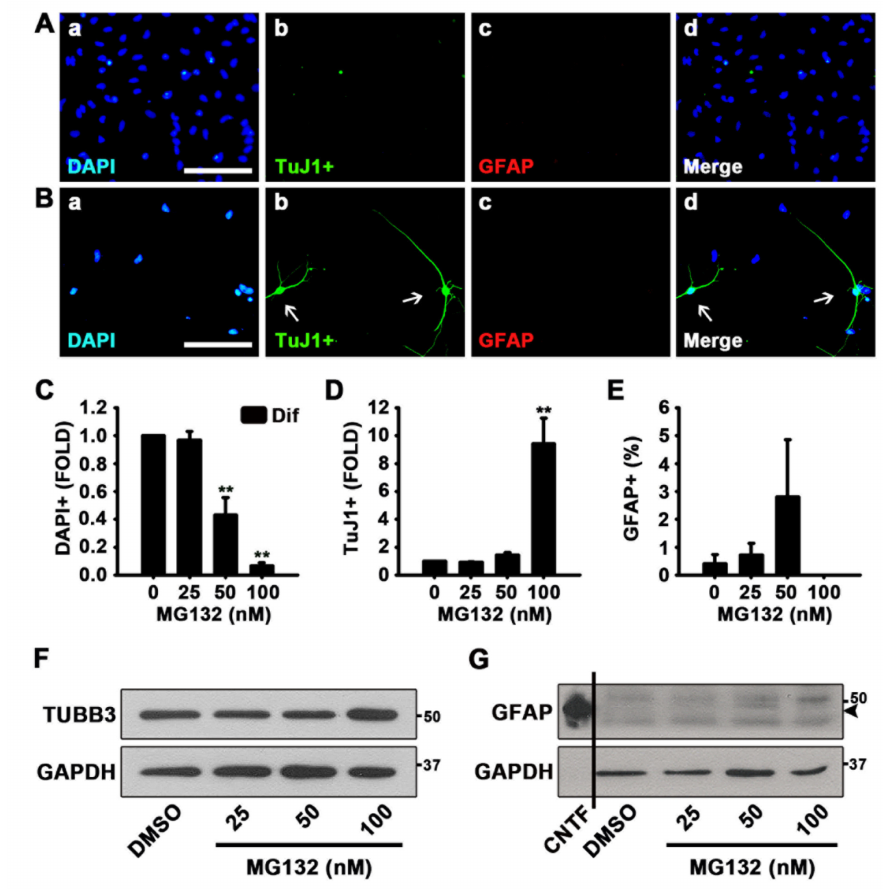
Figure2. MG132increasesthepercentageofneuronsintheabsenceofgrowthfactors. ( A , B )Representative immunofluorescence images of NSCs differentiated for 48 h DAPI-positive nuclei ( a , blue), TuJ1-positive neurons ( b , green), GFAP-positive astrocytes ( c , red), and merged image ( d ). Scale bar = 100 µ m. NSCs were treated with ( A ) DMSO and ( B ) 100 nM MG132 in the absence of epidermal growth factor (EGF) and fibroblast growth factor 2 (FGF2). ( C – E ) Quantification of ( C ) nuclei, ( D ) neurons, and ( E ) astrocytes. Data are expressed as mean ± SEM ( n = 3). ( F , G ) Representative images of the protein bands of ( F ) TUBB3 and ( G ) GFAP. Two days after treatment, total cell lysates from di ff erentiated NSCs were subjected to western blotting analysis with TuJ1 and GFAP antibodies. GAPDH was used as a loading control, and CNTF was used as a positive control for GFAP. ** p < 0.01 (Student’s t